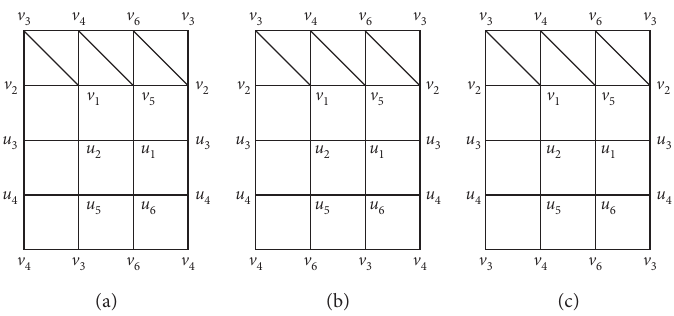
Figure 9: Doubly semiequivelar maps of type [ 3 3 , 4 2 : 4 4 ] [3 3 , 4 2 : 4 4 ] 2 .